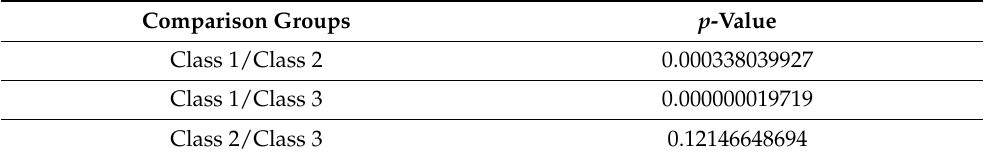
Table 7. The p -value result of pairwise comparisons of classes by spatial structure (for α = 0.05). Comparison Groups